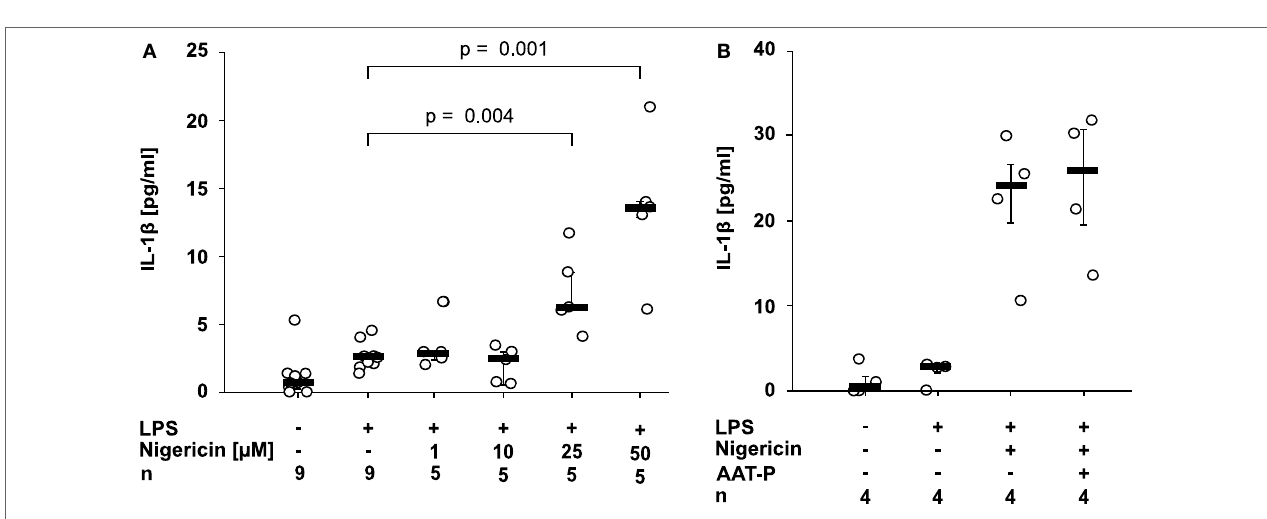
FigUre 1 | Native and oxidized alpha-1 antitrypsin (AAT) inhibit the ATP-dependent release of interleukin (IL)-1 β . (a,B,D) Human lipopolysaccharide (LPS)-primed monocytic U937 cells were stimulated with 2 ′ (3 ′ )- O -(4-Benzoylbenzoyl)adenosine-5 ′ -triphosphate (BzATP, 100 µM) in the presence or absence of different concentrations of the AAT preparation Prolastin ® [ (a) AAT-P], of native AAT purified from the blood of healthy donors (B) and of oxidized AAT (oxAAT) (D) . IL-1 β released to the supernatant was measured after 30 min. Native (c) and oxAAT (e) were separated by SDS-polyacrylamide gel electrophoresis (7.5% acrylamide) and stained with Brilliant Blue. In addition, native AAT from healthy donors (D1–D4) and oAAT were incubated with neutrophil elastase (NE) before electrophoresis. Arrows are pointing to NE (25 kDa), a fragment of AAT (48 kDa), AAT (52 kDa), oxAAT (52 kDa), and to a covalent complex of cleaved AAT and NE (77 kDa). (F,g) BzATP-mediated release of IL-1 β from freshly isolated peripheral blood mononuclear cells (F) or enriched monocytes (g) from healthy human donors in the presence or absence of AAT-P (1 mg/ml). Absolute IL-1 β values obtained from individual donors are connected by lines. (h) Rat precision cut lung slices were primed with LPS followed by application of BzATP in the presence or absence of AAT-P (1 mg/ml). Data are expressed as the concentration of IL-1 β released per milligram lung tissue protein. Data are presented as individual data points, bar represents median, whiskers encompass the 25th to 75th percentile, n -numbers of